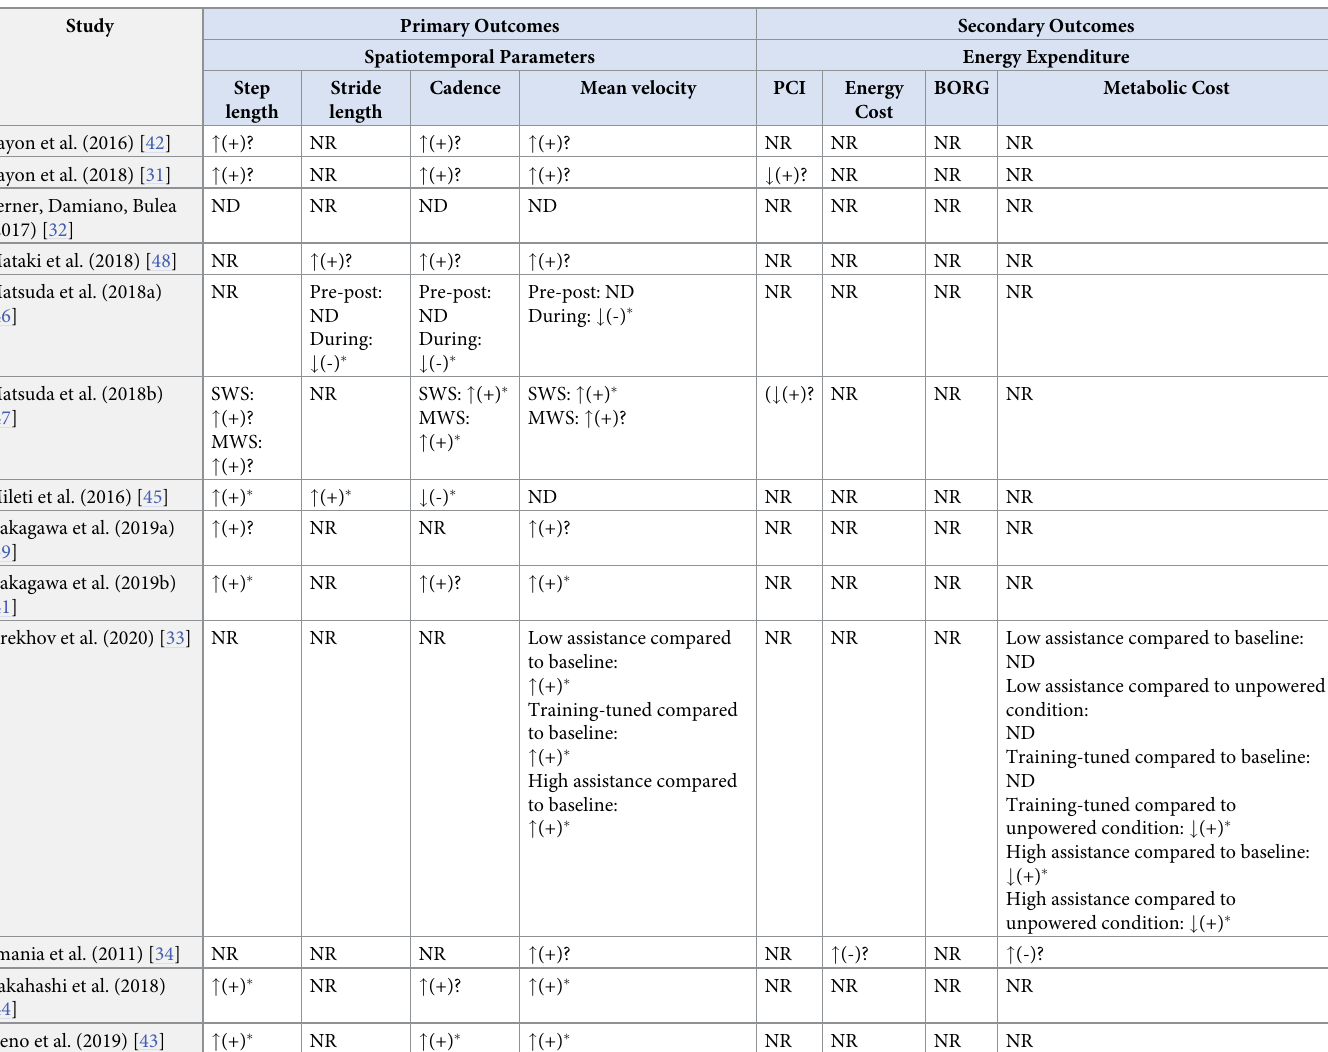
Table 4. Summary of